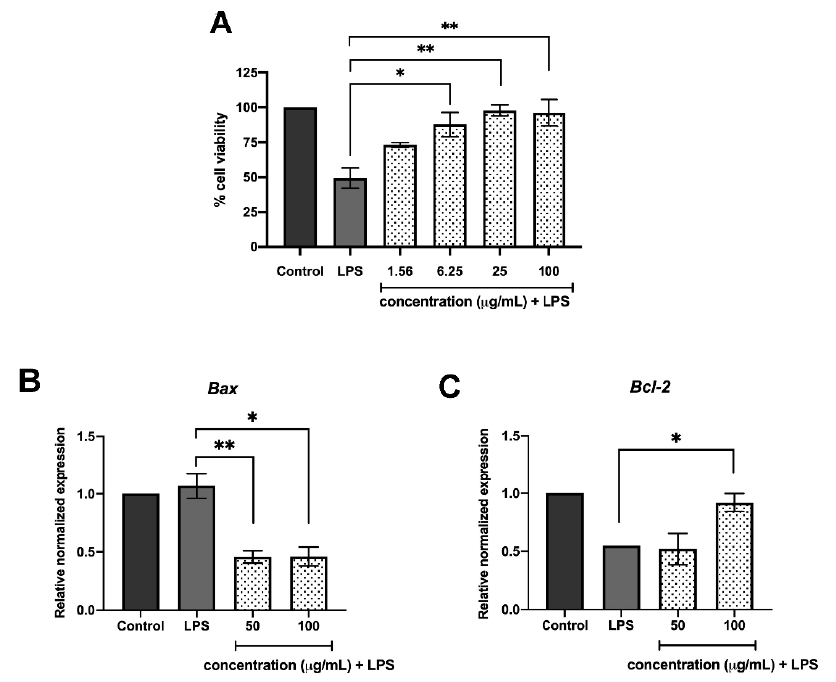
Figure 3. C. nutans extract modulation of apoptosis signaling. ( A ) The efficiency of extract to inhibit LPS-induced cell death was tested using varied doses of extracts in the ranges of 1.56–100 µg/mL. ( B , C ) The effect of the extract on modulation of the expression of apoptosis related Bcl-2 and Bax gene was determined using qPCR. (* indicates p < 0.05, ** indicates p < 0.01, and *** indicates p < 0.001) .